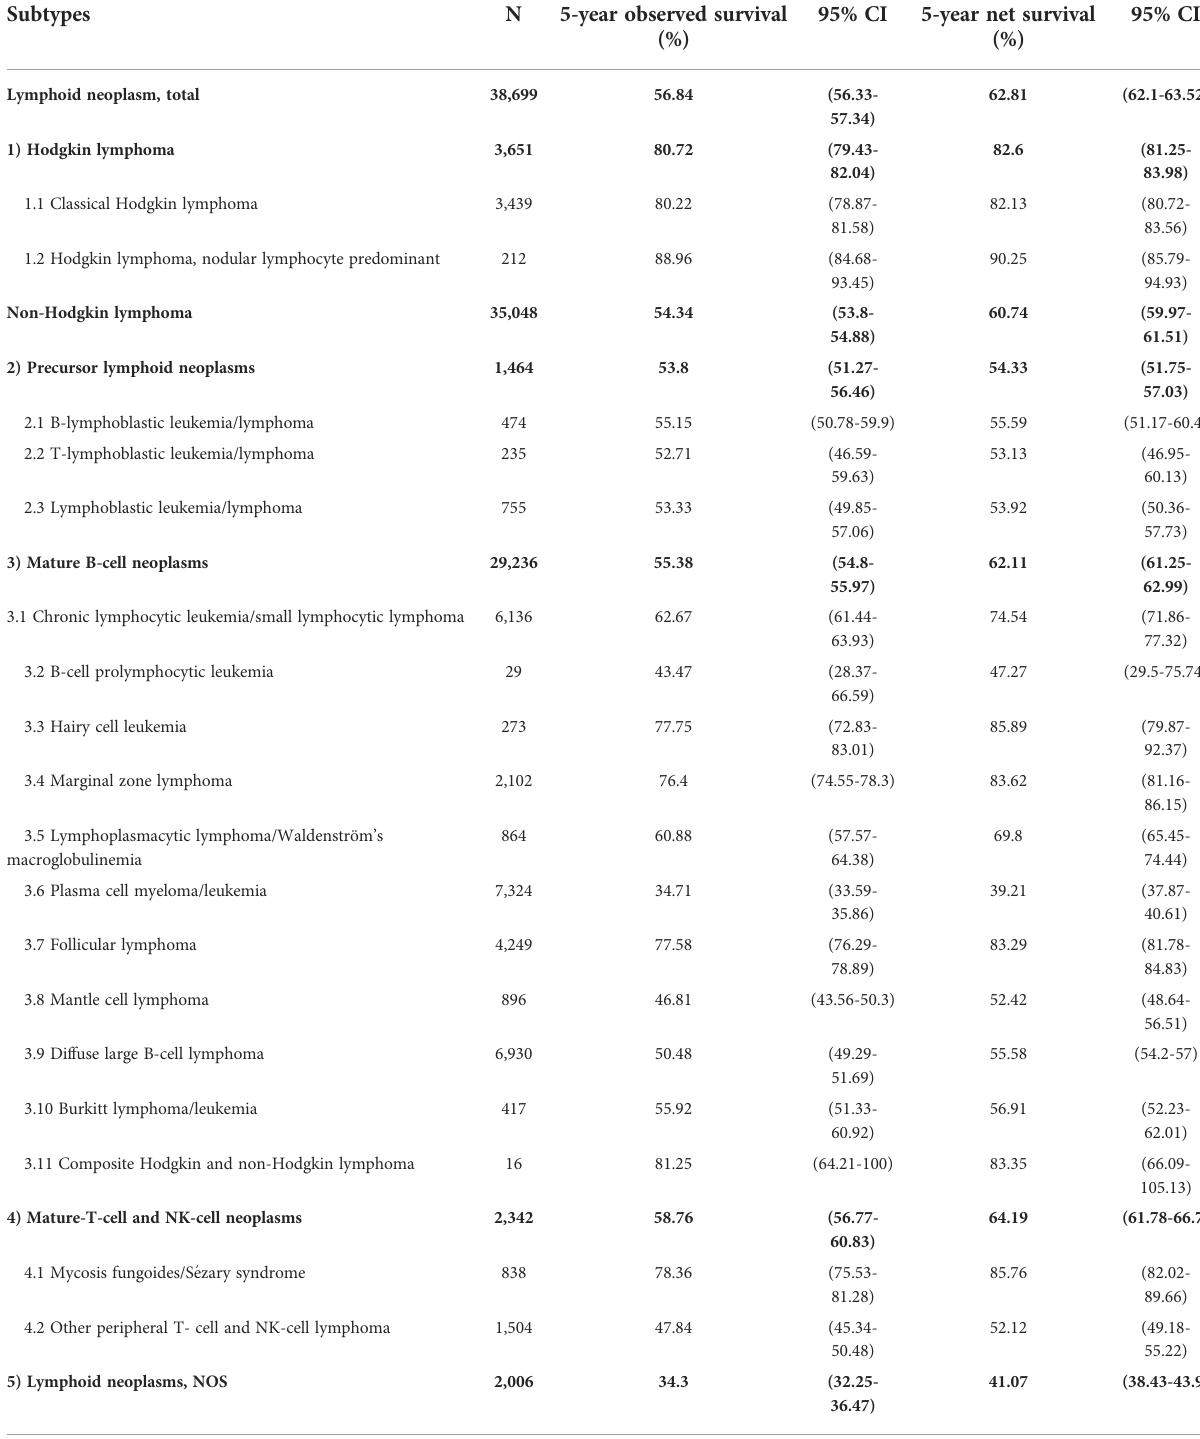
TABLE 3 Five-years observed and net survival of lymphoid neoplasms in Spain.